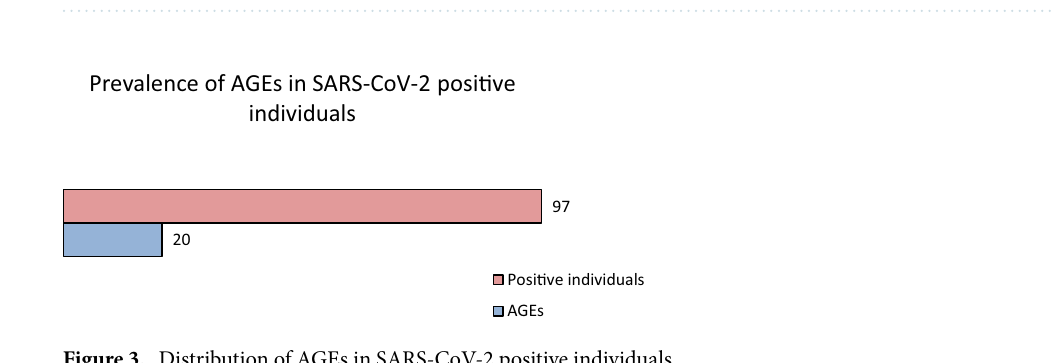
Table 1. Baseline characteristics in all individuals compared with individuals presenting AGEs in the study group.